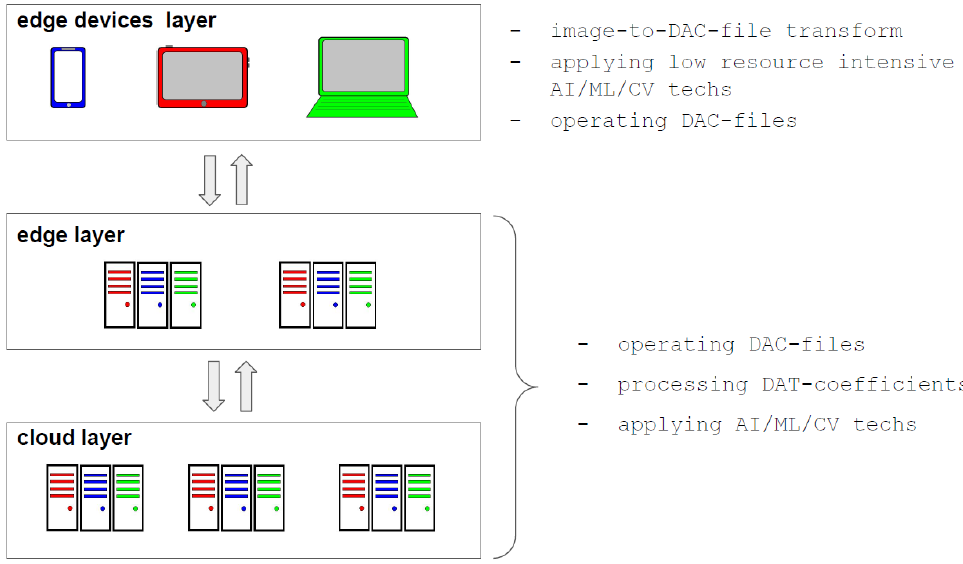
Figure 18. Application of atomic functions in image processing for EC in IoT systems.